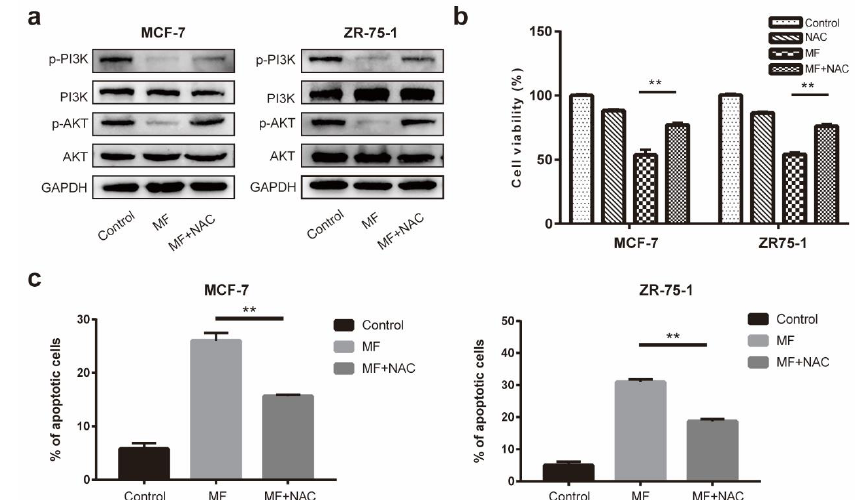
Figure 5. MF inhibited the activities of the PI3K / AKT signaling pathways through ROS accumulation in MCF-7 and ZR-75-1 cells. ( a ) Western blotting was performed to analyze the expression levels of PI3K, p-PI3K, AKT and p-AKT in MCF-7 and ZR-75-1 cells after MF (200 Hz, 1 mT, 24 h) and MF + NAC (N-acetyl- l -cysteine) treatment. ( b ) The viabilities of MCF-7 and ZR-75-1 cells after